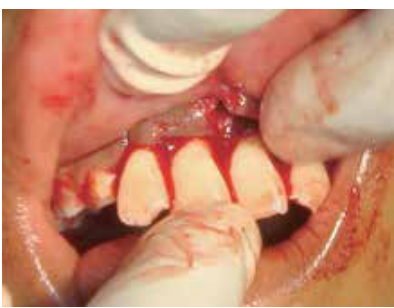
Fig 6. Functional splint